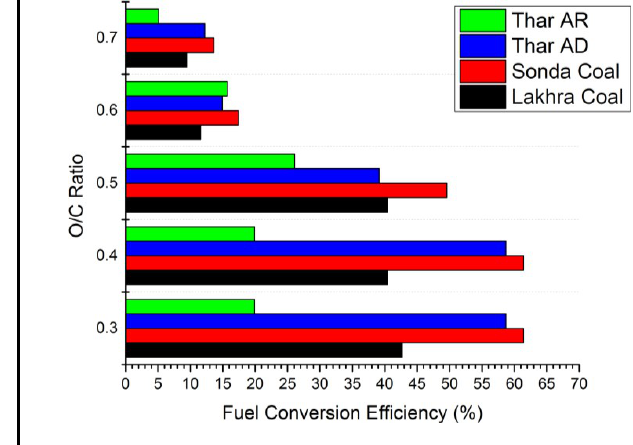
FIG. 7. TEMPERATURE OF EXIT SYNGAS FOR VARIOUS FEED STOCKS